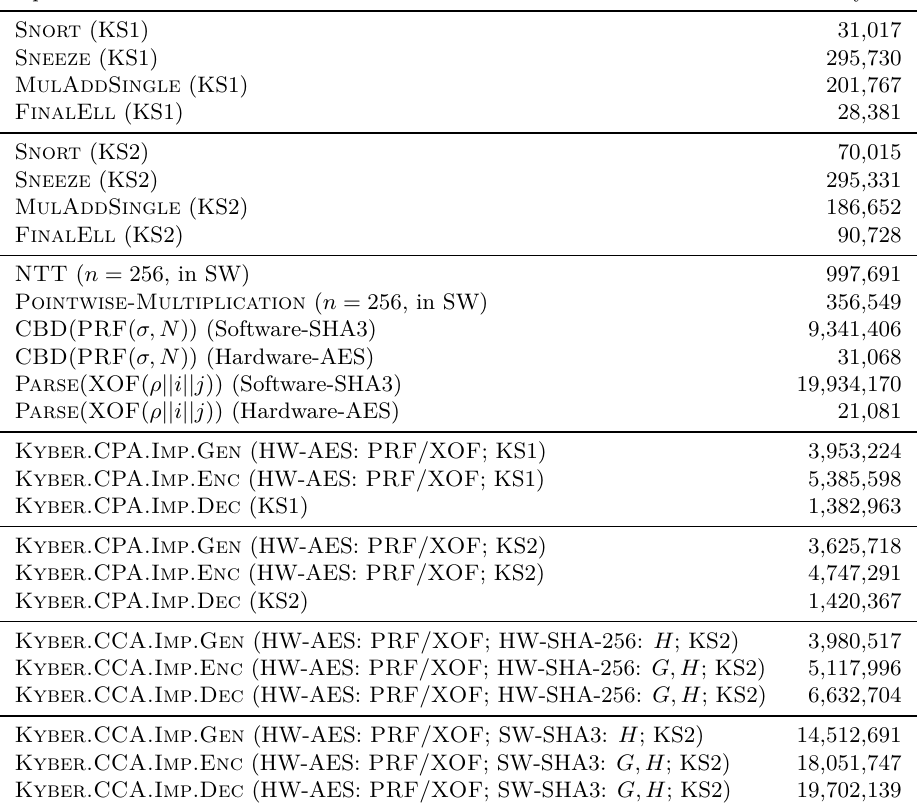
Table 2: Performance of our work on the SLE 78 target device in clock